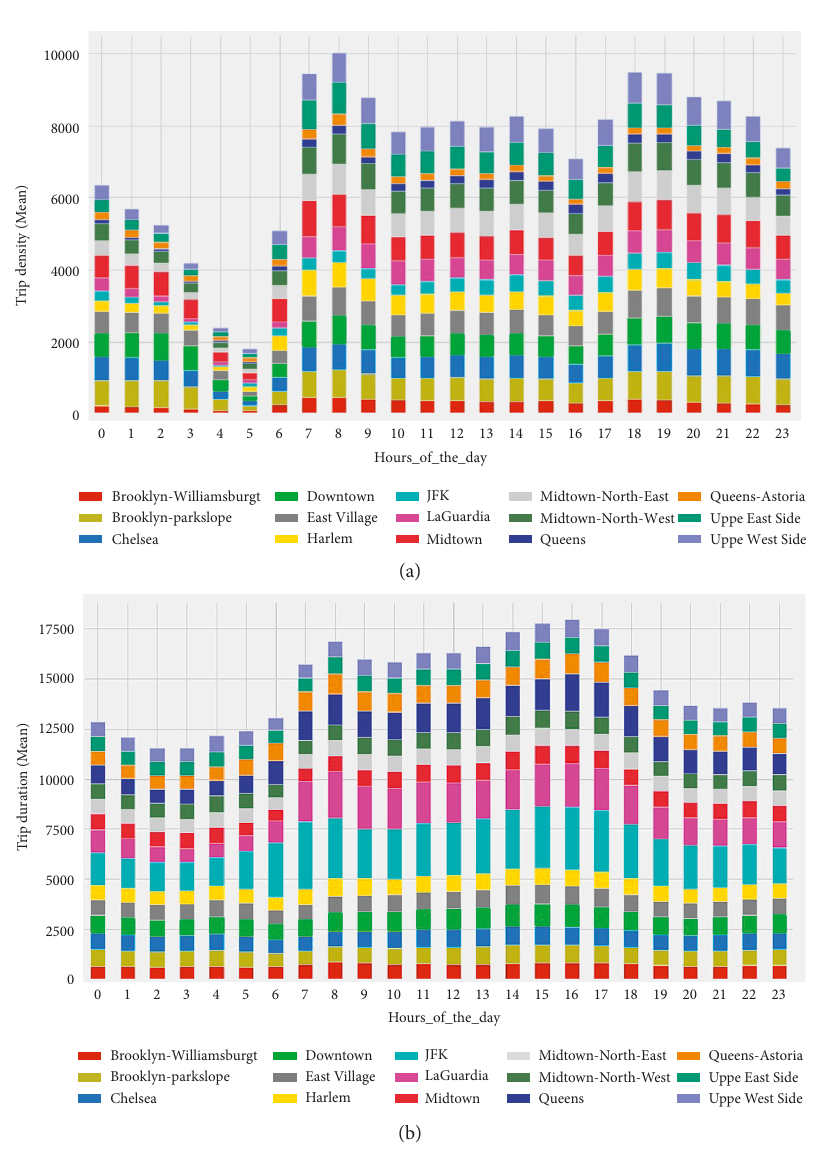
Figure 1: Traffic pattern visualization for city boroughs. (a) Average rate of trip density. (b) Average rate of trip